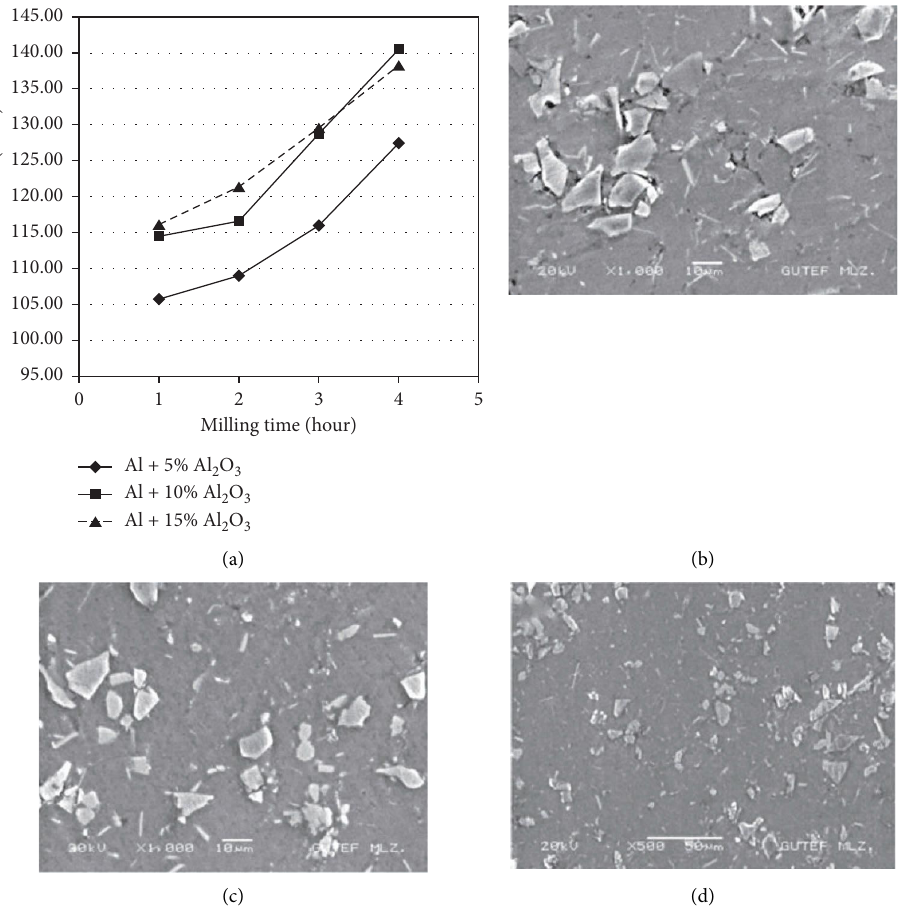
Figure 12: (a) VH of samples with various Al 2 O 3 wt% and milling times. After sintering, SEM of Al + 10 wt% Al 2 O 3 composite milled at different times: (b) 1h (c) 2h, and (d) 3 h, reproduced with permission from Ref. [79], copyright 2021, Wiley Online